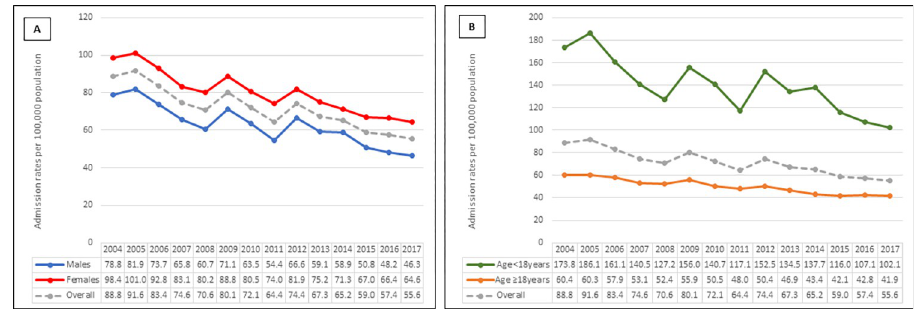
Fig 1. Annual rates of asthma admissions by (A) sex and (B) age of patients admitted between 2004 and